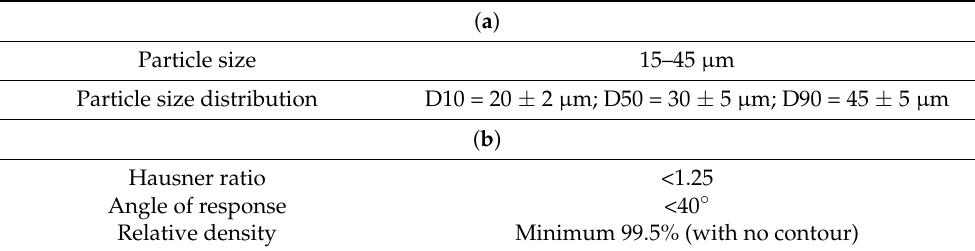
Table 2. Inconel 625 powder characteristics: ( a ) powder dimensions; ( b ) powder